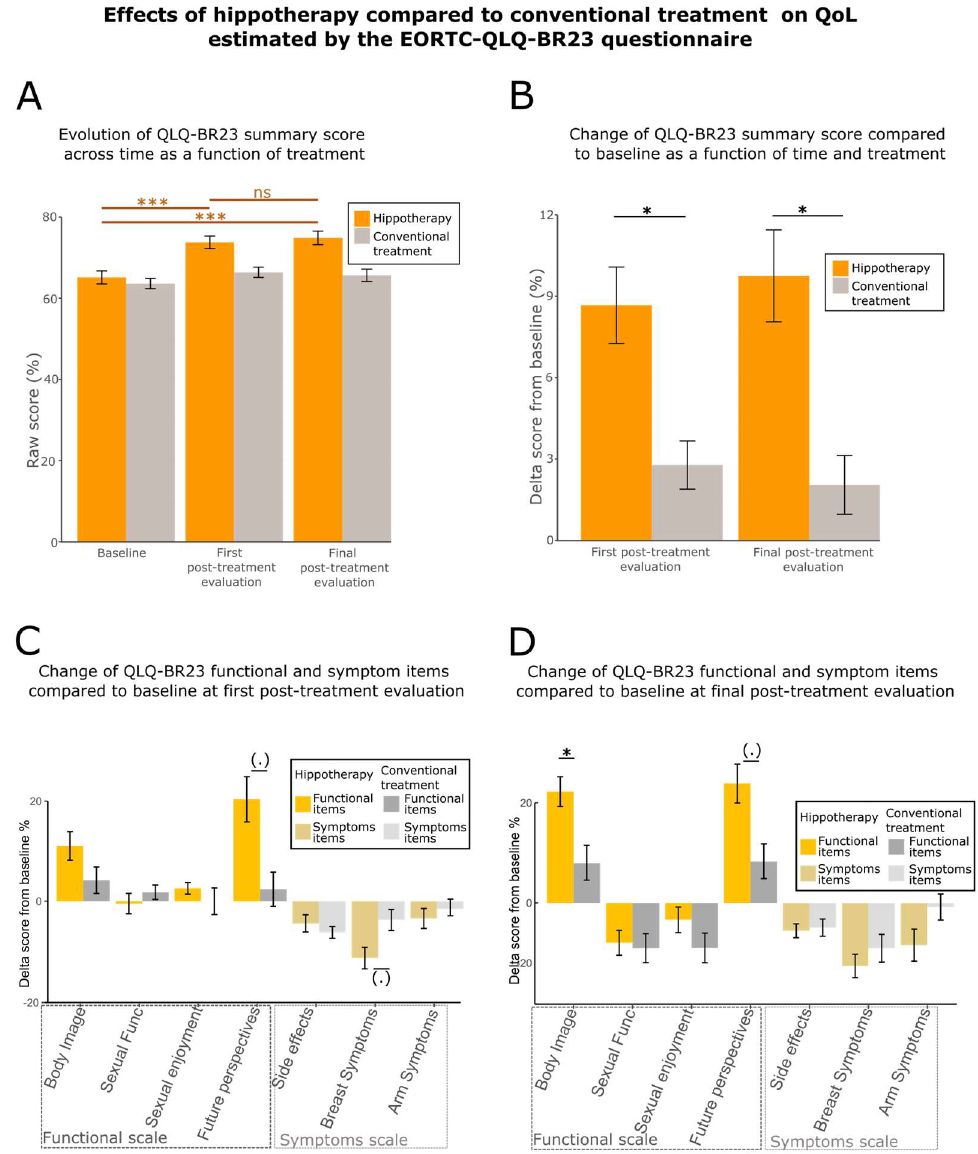
Figure A1. Effects of hippotherapy treatment compared to conventional treatment on QoL, as estimated by the EORTC-QLQ-BR23 questionnaire. A) Bar chart represents means (M) and standard errors of means (SEM) of the evolution of QLQ-BR23 scores across time as a function of the treatment type. Values (M ± SD) are as follows: Baseline = 65.1 ± 12.8, First post-treatment evaluation = 73.8 ± 12.4, Final post-treatment evaluation = 74.9 ± 13.3 for the hippotherapy group; Baseline = 63.6 ± 10.2, First post-treatment evaluation = 66.4 ± 10.2, Final post-treatment evaluation = 65.7 ± 12.2 for the control group. B) Change of score compared to baseline QLQ-BR23 score (M ± SEM), as a function of time and treatment. Values (M ± SD) are as follows: First post-treatment evaluation = 8.67 ± 11.2, Final post-treatment evaluation = 9.99 ± 13.7 for the hippotherapy group; First post-treatment evaluation = 2.78 ± 7.11, Final post-treatment evaluation = 2.26 ± 8.74 for the control group. C) Comparison of score changes for the QLQ-BR23 subsets between the two groups at first post-treatment evaluation. D) Comparison of score changes for the QLQ-BR23 subsets between the two groups at final post-treatment evaluation. (***) p < 0.001; (*) p < 0.05; (.) close to significance (between 0.08 and 0.05); (ns) non-significant.